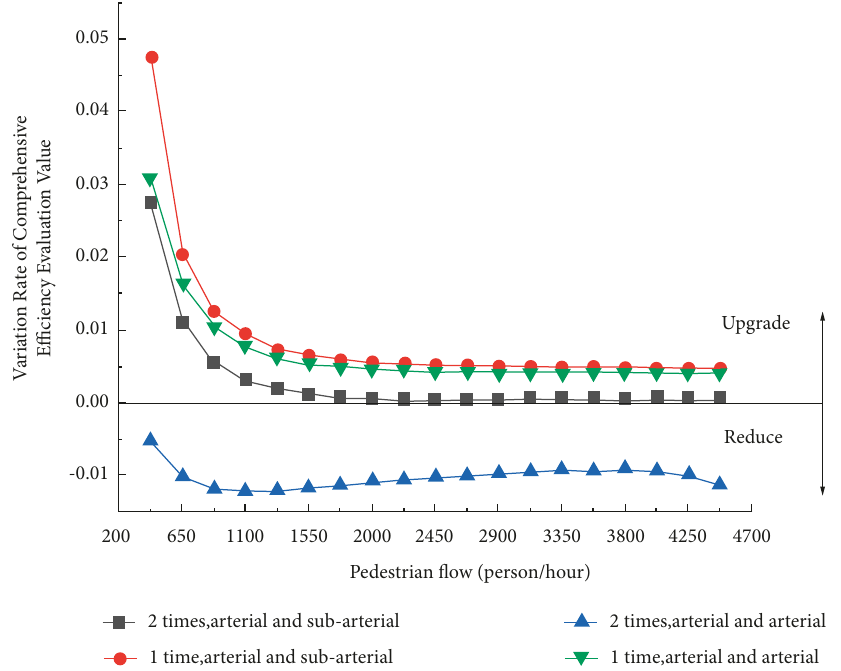
Figure 16: Relationship between variation rate of comprehensive efficiency evaluation value at intersection and pedestrian flow volume.